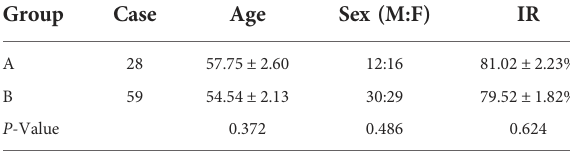
TABLE 1 The general patients